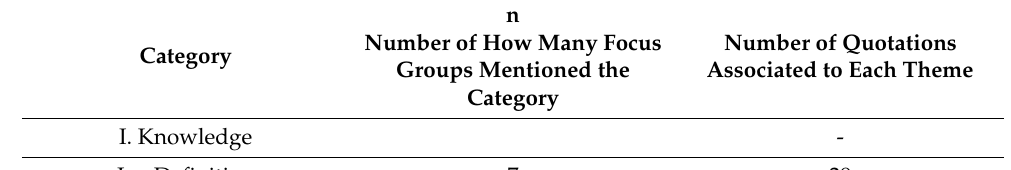
Table 2. Content analysis of the focus